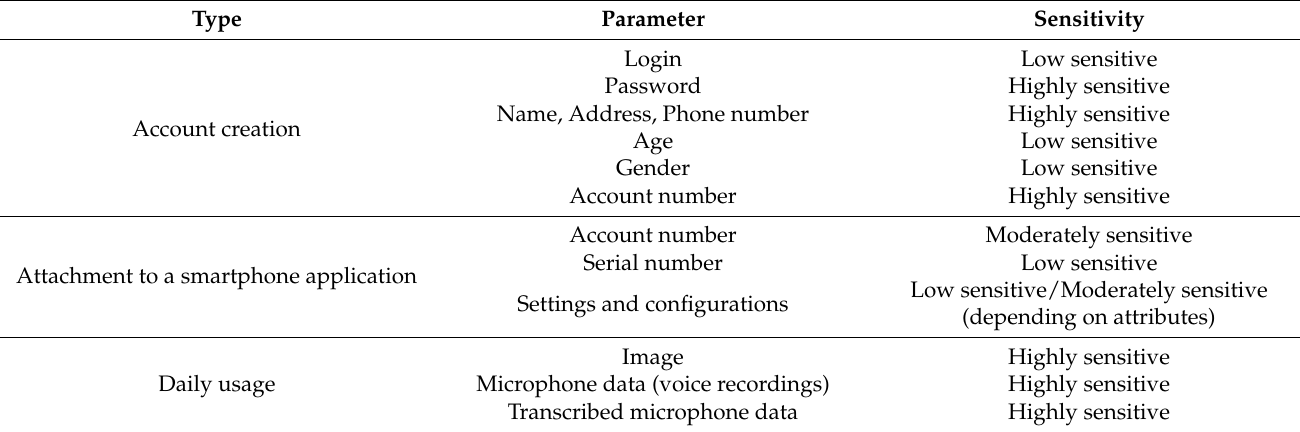
Table 3. Classification of data sensitivity